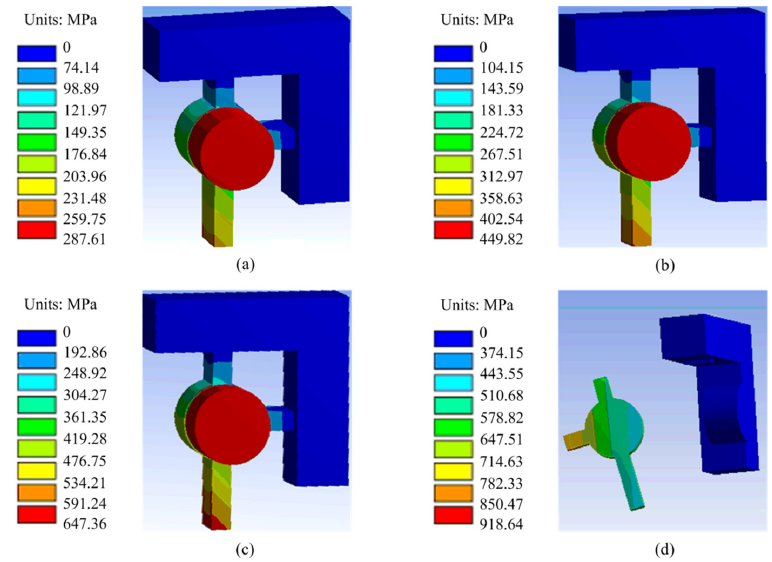
Figure 9. Fracture of the shear pin. ( a ) 10N; ( b ) 20N; ( c ) 30N; ( d ) 40N.